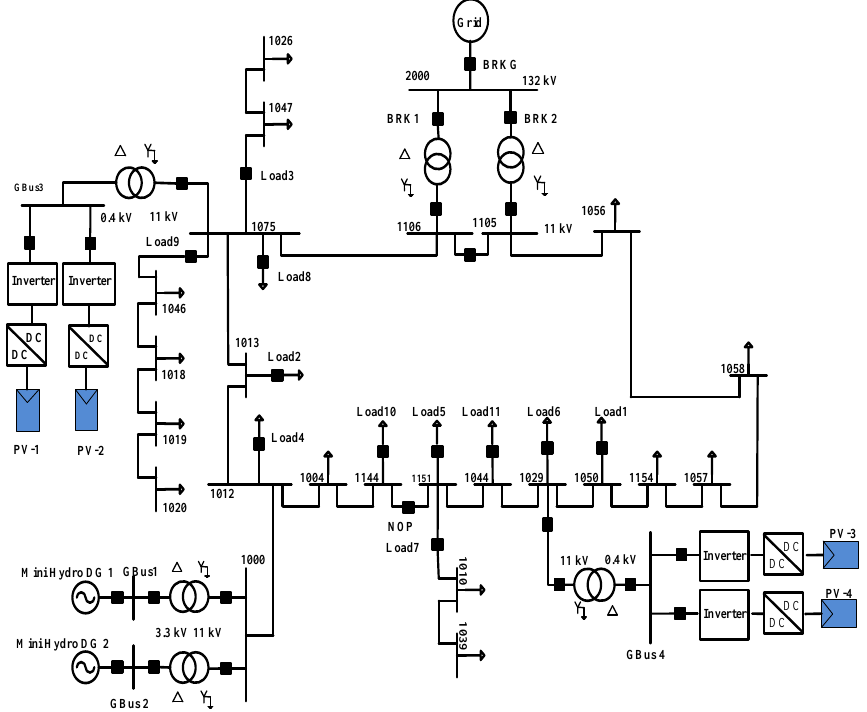
Figure 13. The distribution network for validation of proposed Under Frequency Load Shedding (UFLS) technique.